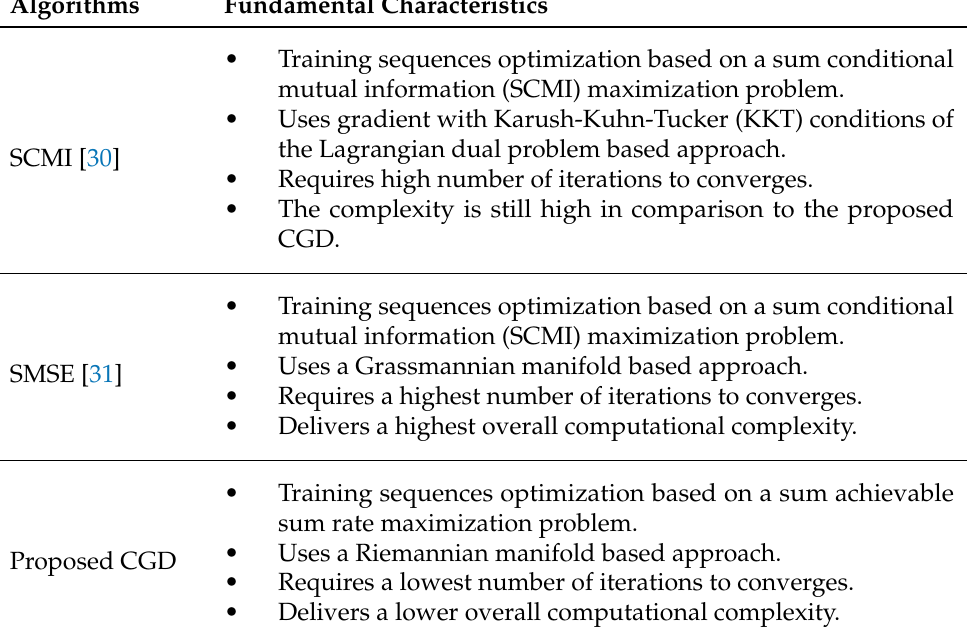
Table 8. Comparison between the methods to compare the fundamental characteristics of the proposed method with the